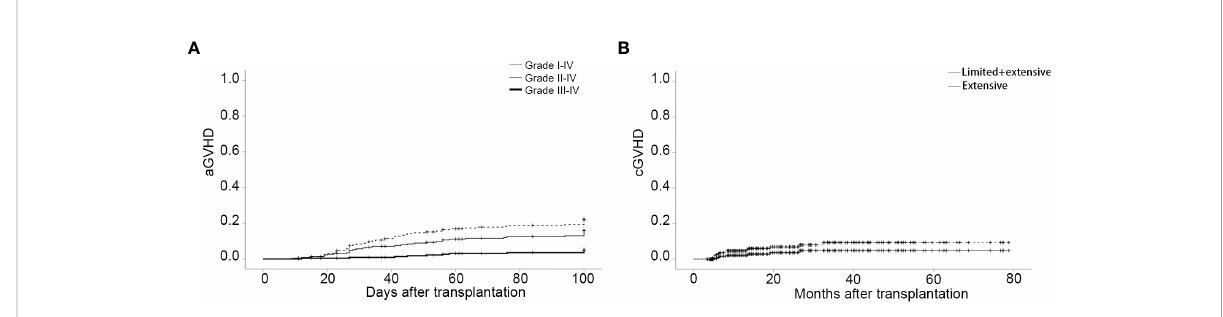
FIGURE 1 CIs of aGVHD and cGVHD. (A) The 100-day CI of grade I-IV aGVHD, II-IV aGVHD and III-IV aGVHD. (B) The CI of cGVHD and extensive cGVHD.